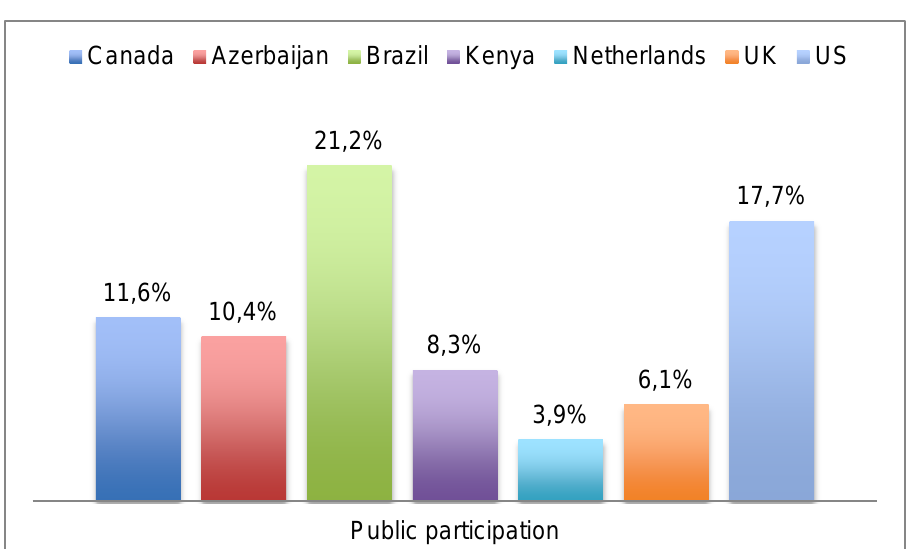
Figure 3: Salience of the code “Public participation” by country Action Plan